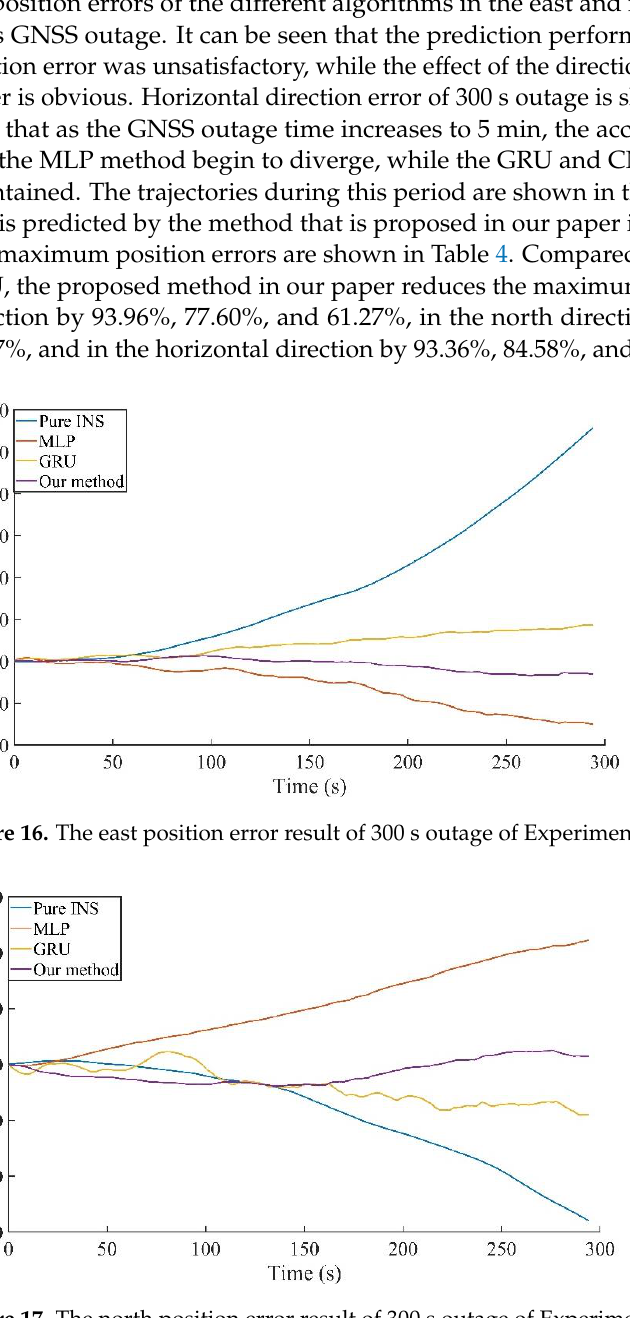
Figure 18. The horizontal position error result of 300 s outage of Experiment 1. Figure 19. The trajectories of 300 s outage of Experiment 1. Table 4. Maximum position error of 300 s outage of Experiment 1. East Error (m)